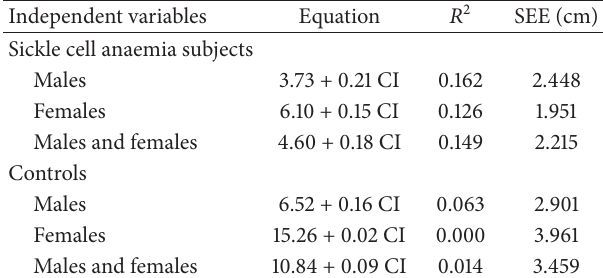
Table 4: Regression of BMI on Cormic Index of subjects and